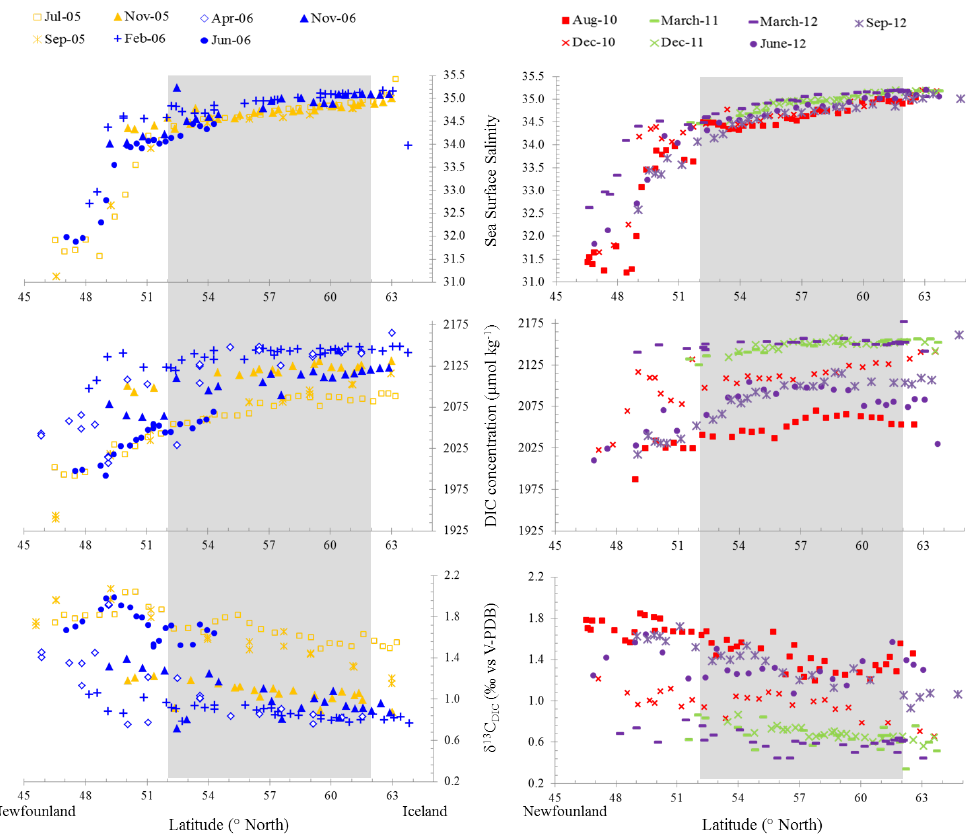
Fig. 2. Surface distribution of salinity (top panel), dissolved inorganic carbon concentration (DIC, middle panel) and δ 13 C DIC (bottom panel) between Reykjavik (Iceland, 64 ◦ N) and Newfoundland (Canada, 47 ◦ N) over the periods 2005–2006 (left panel) and 2010–2012 (right panel). The interior of the North Atlantic subpolar gyre (NASPG, 53 ◦ N–62 ◦ N), our study area, is delimited by the light grey box. Any salinity measurements are realized in April 2006. August 2010 (full red square) distinguishes itself by a lower DIC concentration observed over both periods but without higher δ 13 C DIC